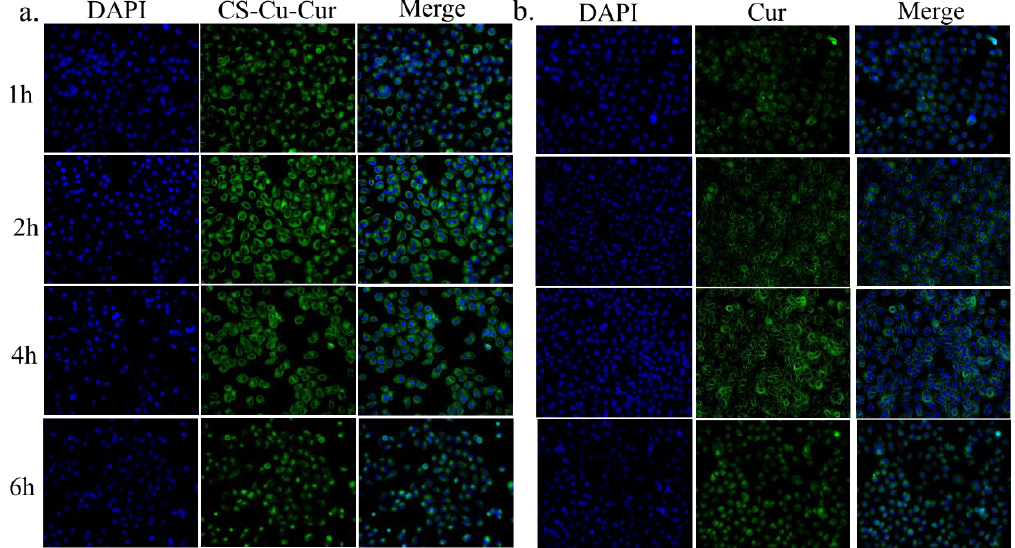
Figure 9. Confocal laser scanning microscope images of intracellular uptake of ( a ) Cur-loaded CS nanocomplex and ( b ) pure Cur by H1299 cells. Concentration of Cur is 20 ug/mL.